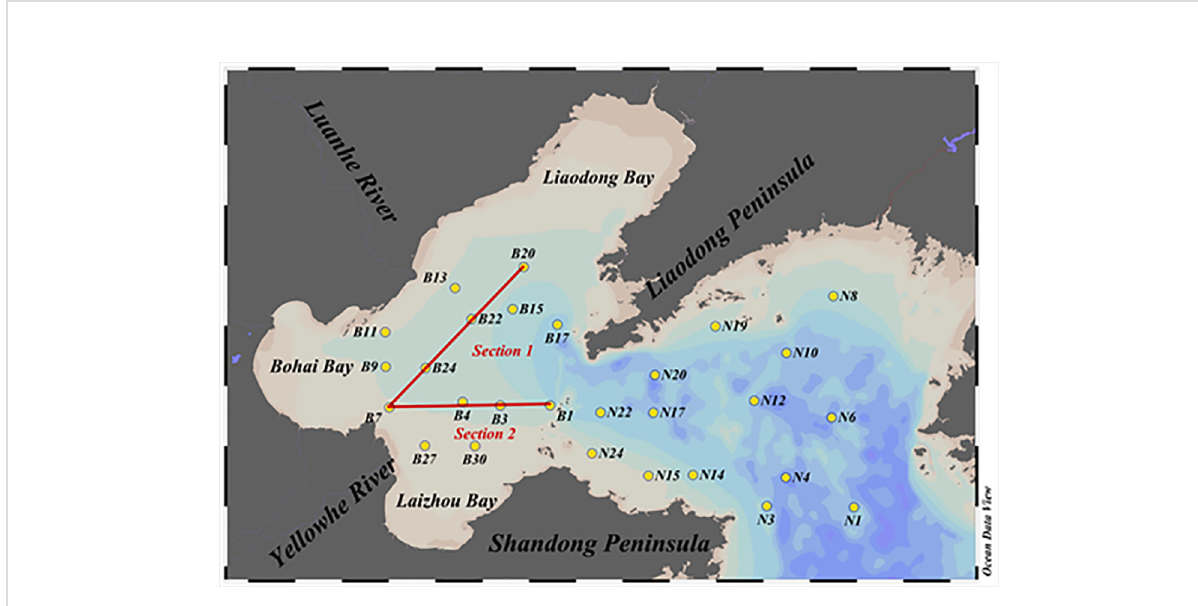
FIGURE 1 Location of the sampling stations in BS and NYS in summer and